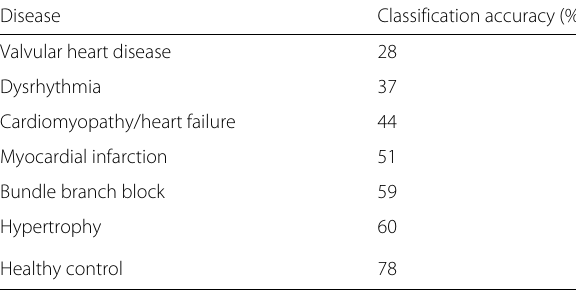
Table 12 Results of per-disease classification accuracy Disease Classification accuracy